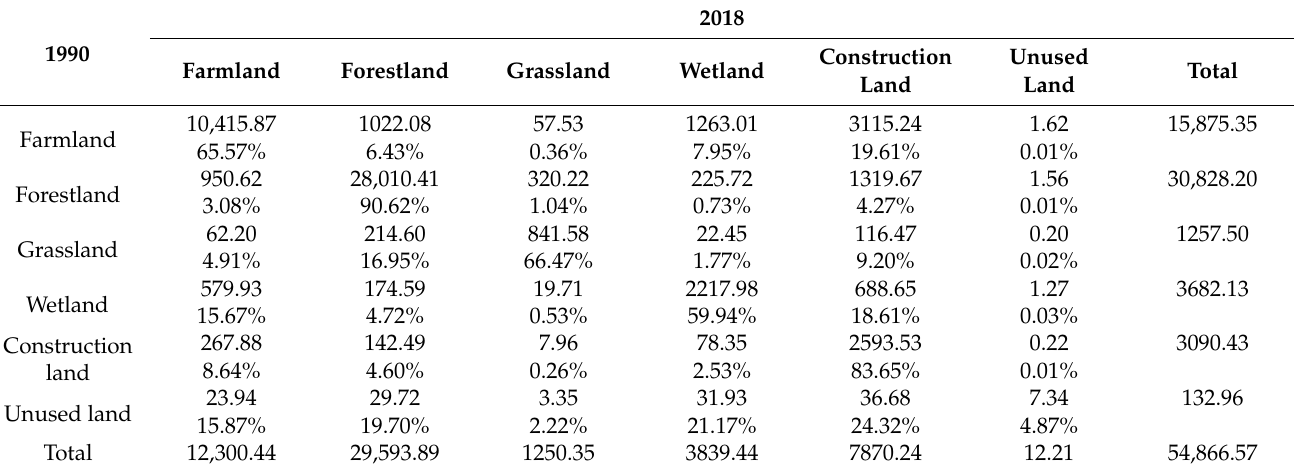
Table 2. Land-use transfer matrix of the GBA, 1990–2018 (unit: /km 2